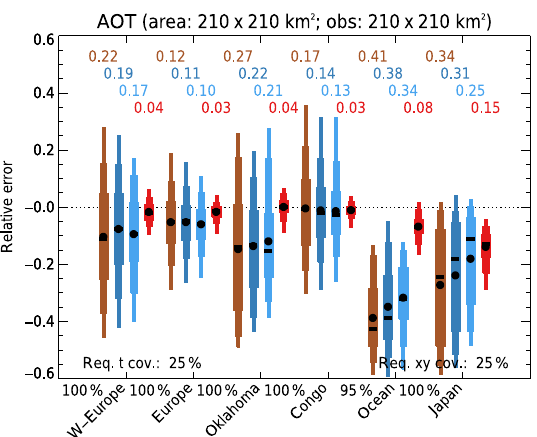
Figure 13. Monthly representation errors for an imager on a polar- orbiting satellite due to different data treatments: no collocation (brown), no collocation but using super-observations (dark blue), no collocation but area data and super-observations log-transformed (light blue), and area data collocated to the hour (red). The brown and red error estimates are identical to Fig. 12a. Results for a repeat cycle of 1 day. Further explanation in Sect.